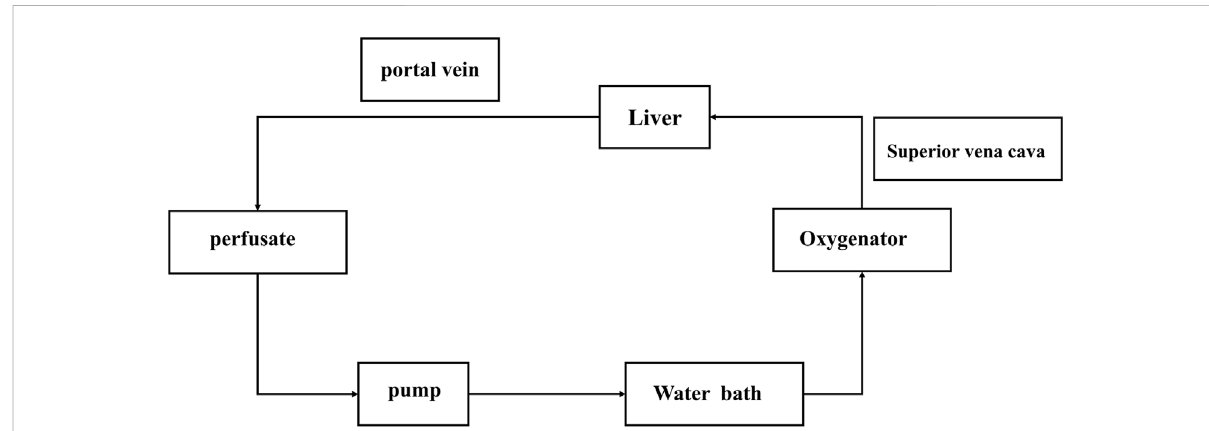
FIGURE 1 Normothermic machine perfusion system. The pump is the main switch of the system. After the corresponding parameters are set, the fi lling liquid starts to fl ow. After the perfusate fl ows through the pump (if has bubbles, they will be displayed here, and the perfusion will be stopped immediately), it will connect to the blood inlet end of the oxygenator, the bleeding end will be connected to the portal vein of the liver, and the perfusate will fl ow back to the infusion bottle from the superior vena cava end of the liver after fl owing through the